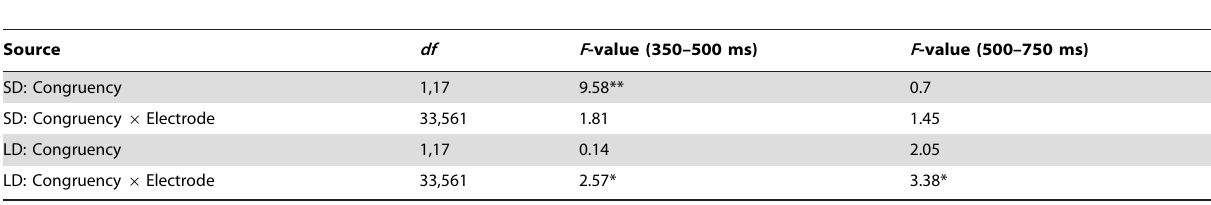
Table 2. Mean ERP amplitude ANOVAs for pronoun position.